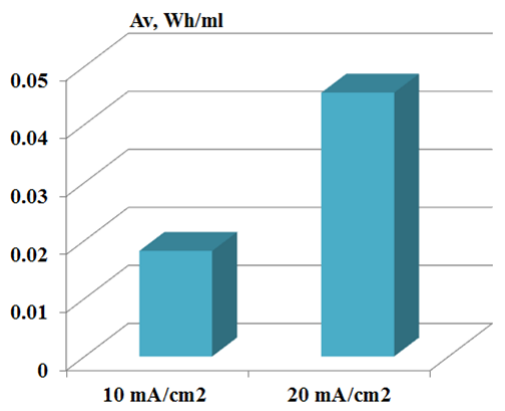
Figure 9. Variations of total specific energy consumption per unit of volume Av (W·h·ml -1 ) at j =10 and 20 mA·cm -2